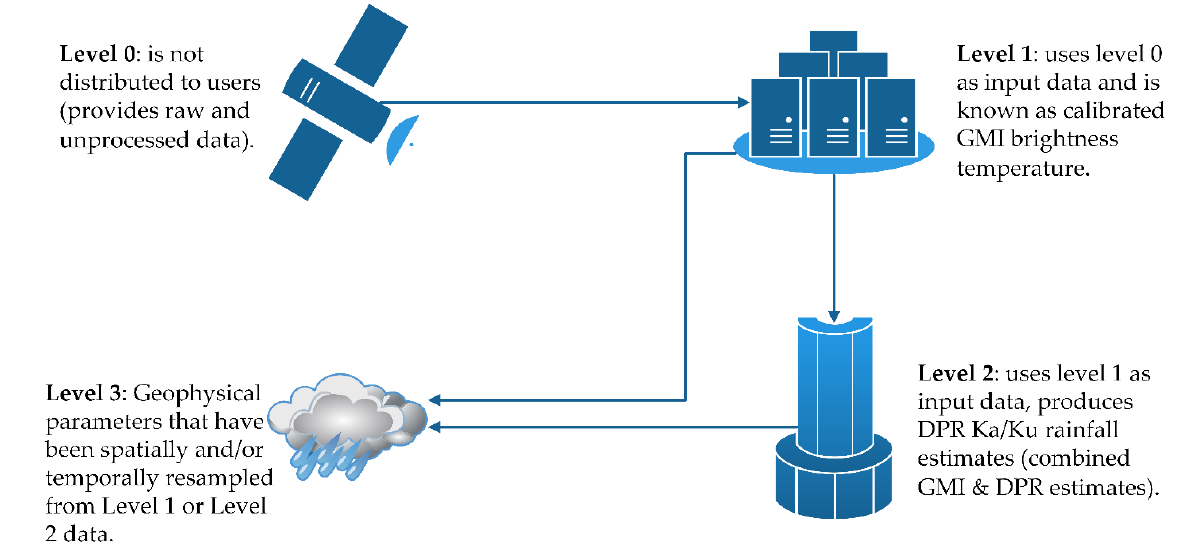
Figure 3. Definition of GPM SPP levels.